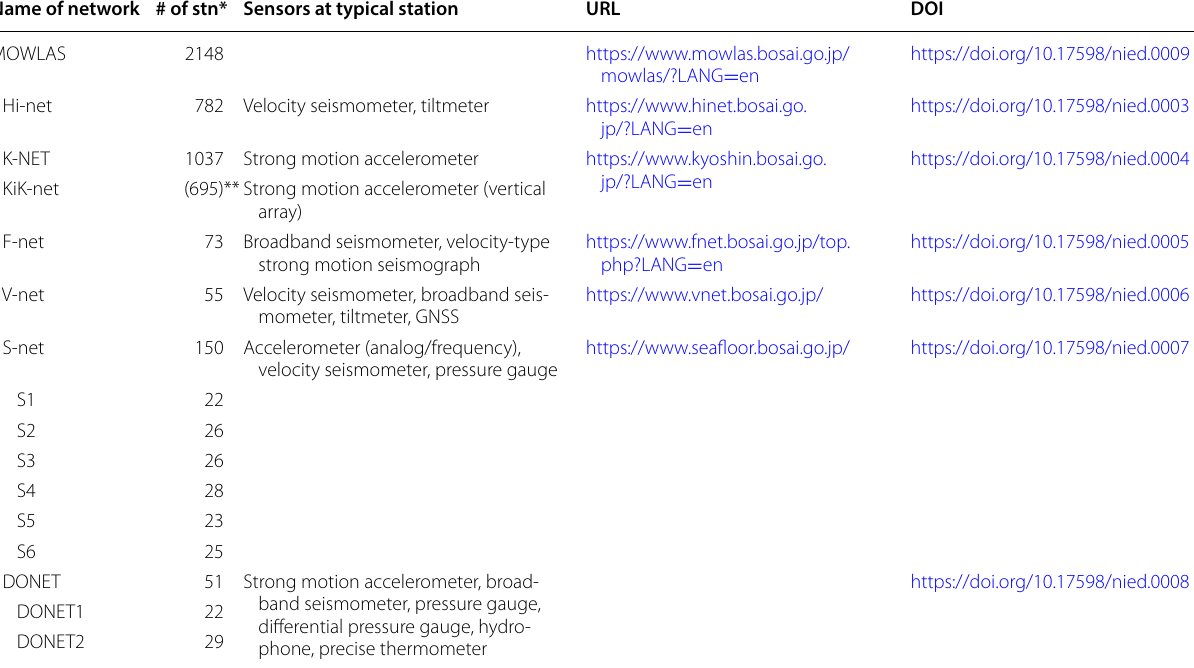
Table 1 Information on MOWLAS stations, including their numbers, sensors, URLs, and